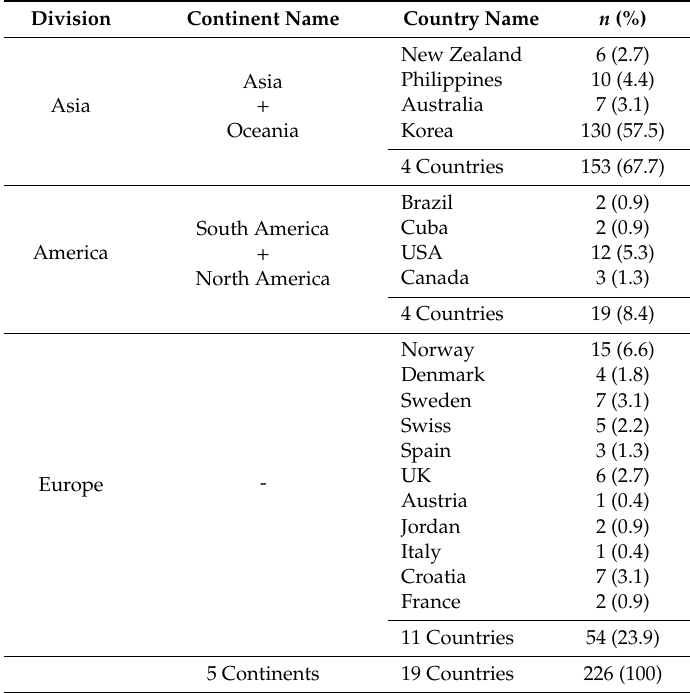
Table 1. The distribution of respondents by each